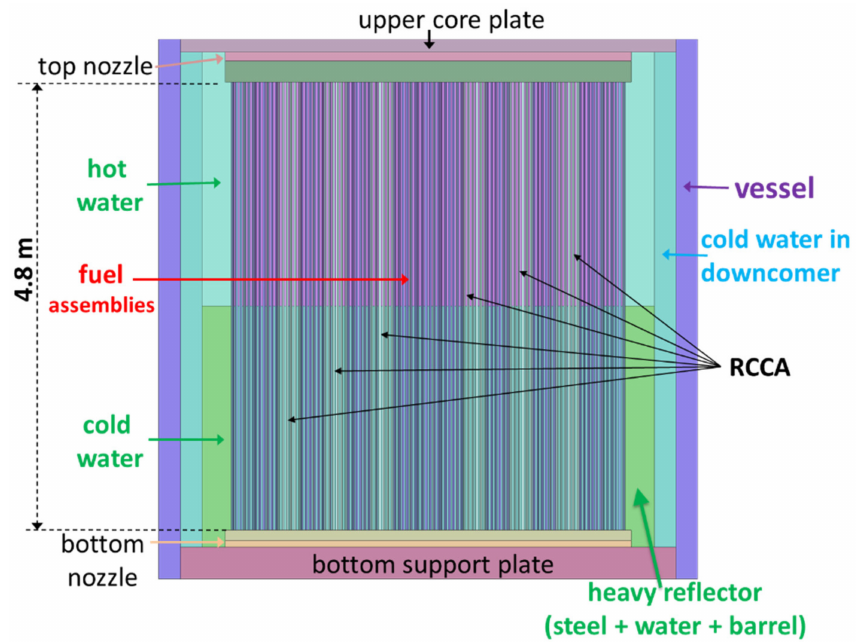
Figure 3. EPR 3D full-core geometry specified using Serpent (axial view with simplified thermal hydraulic description for illustration